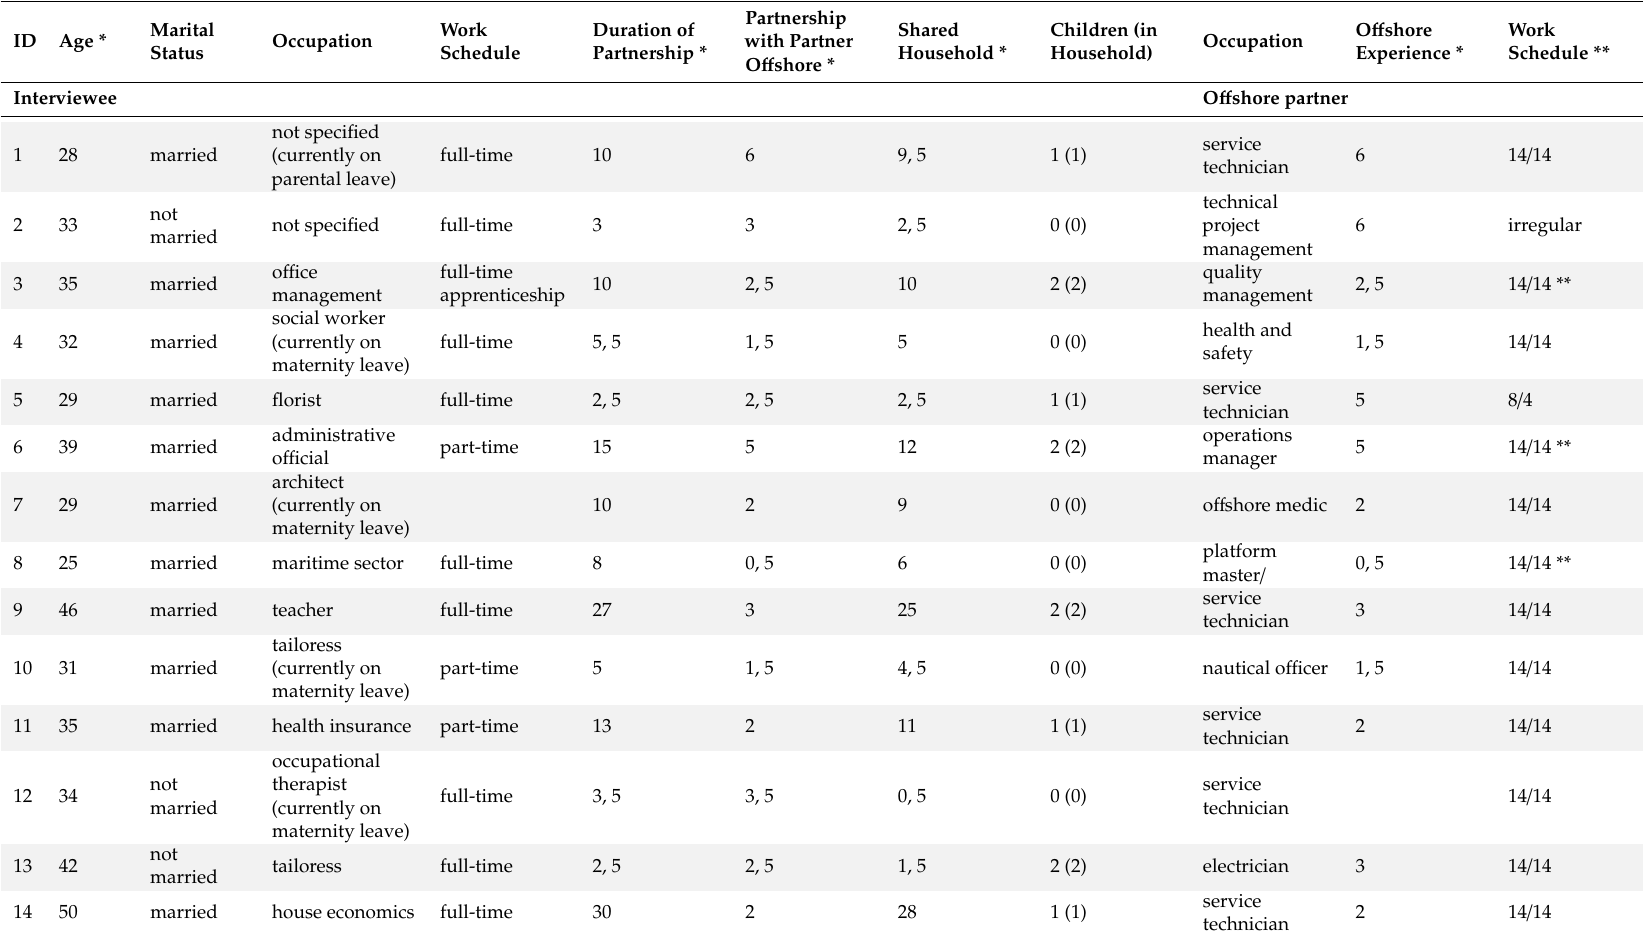
Table 3. Participant characteristics (in